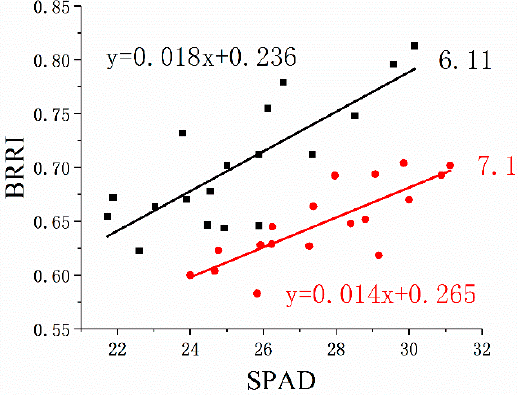
Figure 11. BRRI-SPAD model for different periods. The data acquired on June 11 is represented by a black square, and the data acquired on July 1 is represented by a red circle. The data were obtained at 11:00–13:00, and the weather conditions were the same. Source: Built on the basis of the author’s field survey and calculations.